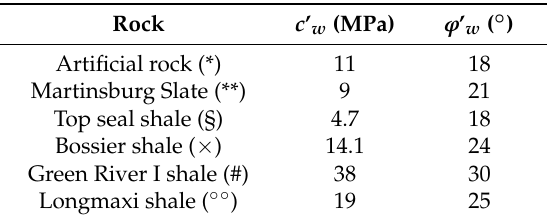
Table 1. Strength parameters of the weakness planes of the rocks. Rock c ’ w (MPa) ϕ ’ w ( ◦